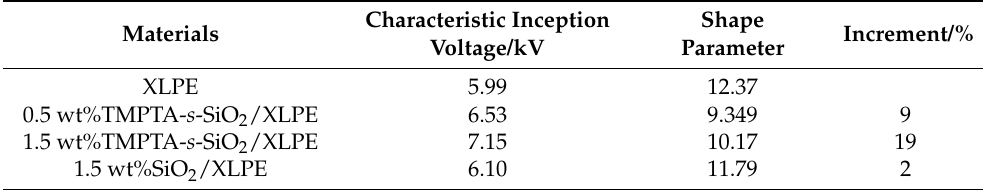
Figure 5. Weibull 2-parameter distributions of the electrical-tree inception voltages for XLPE and its nanocomposites. Table 2. Characteristic electrical-tree inception voltages at 63.2% probability and shape parameters of 2-parameter Weibull statistics at 95% confidence interval.